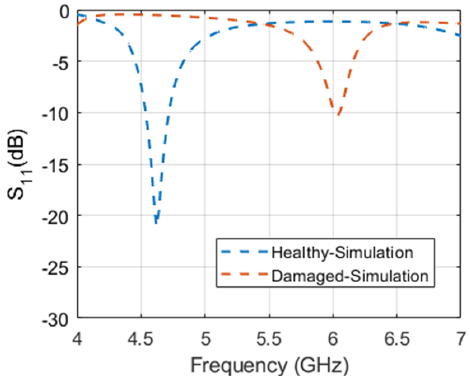
Figure 2. Magnitude of the re fl ection coe ffi cient of the simulated patch antenna in pre- and post- damage in fl iction.